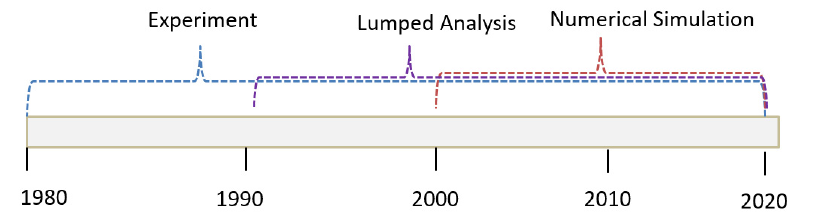
Figure 1. Evolution of thermal analysis.